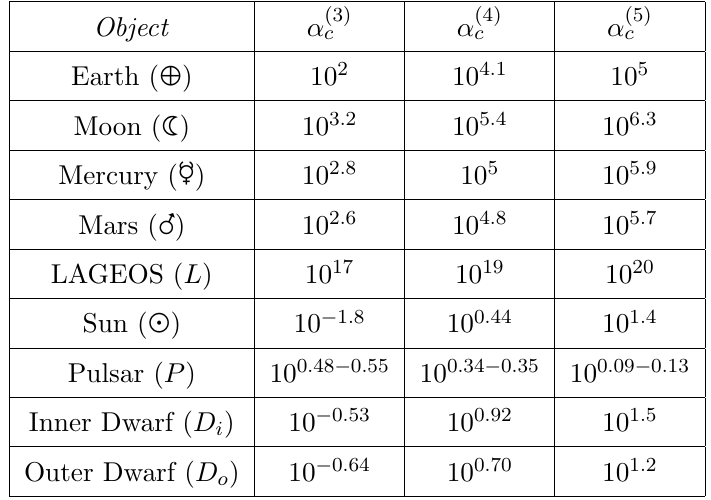
Table 1 . Critical values (cid:11) c of the force strength relative to gravity for natural-sized scalar cubic, quartic and quintic self-interactions. For (cid:11) ¡ (cid:11) c the scalar (cid:12)fth force becomes screened. Due to uncertainty in the neutron star equation of state, we provide a range of (cid:11) c for the pulsar in PSR J0337 (cid:0) 1715 , where we have used the upper and lower bounds on the radius of a neutron star